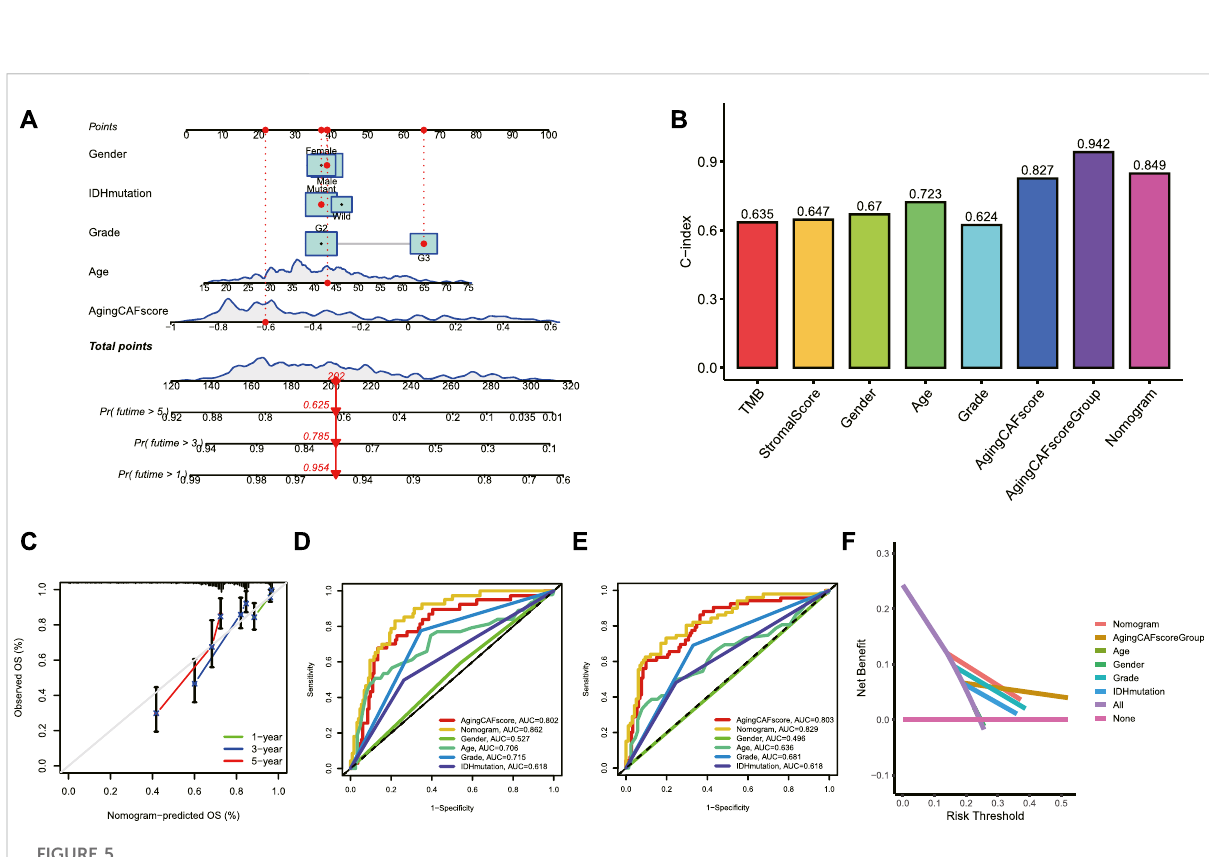
FIGURE 5 Construction of a nomogram model. (A) Nomogram model based on the aging CAF score and multiple clinicopathological factors was constructed. (B) Values of the C-index for the nomogram model and aging CAF score group were higher than those of other clinical factors. (C) Calibration curves for the nomogram model. (D,E) ROC curves of the nomogram model for predicting the 2 (D) and 3-year (E) overall survival. (F) DCA of the nomogram model for predicting the prognosis at 3 years. CAF, cancer-associated fi broblast; C-index, consistency index; ROC, receiver operating characteristic; AUC, area under curve; DCA, decision curve